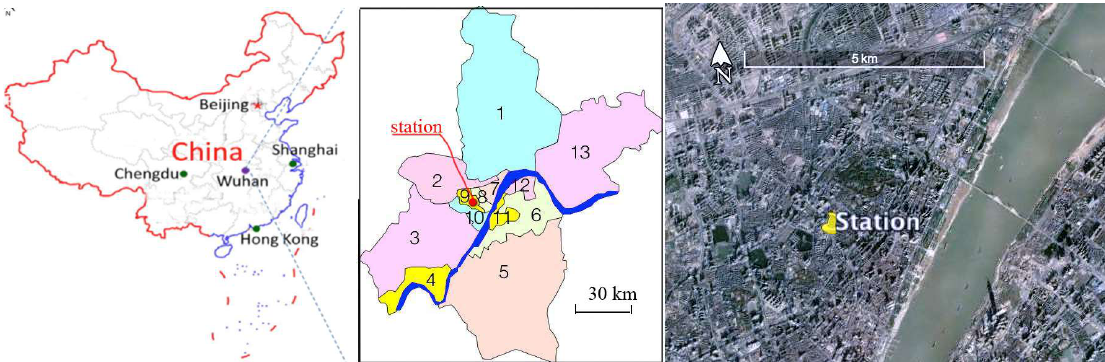
Figure 1. Location of Wuhan (left panel) and monitoring station in the Wuhan district map (middle panel), and aerial photograph around the station (right panel) (source: google.com).